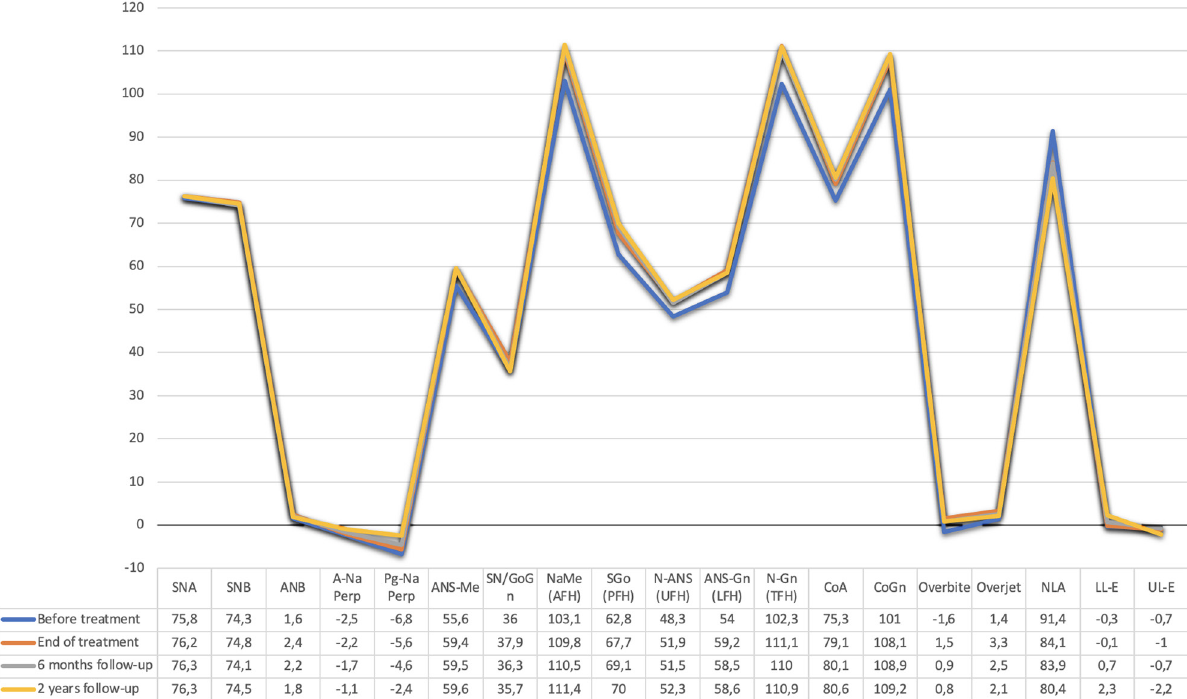
Figure 8. Graphical representation of cephalometric changes that occurred because of orthodontic treatment and subsequent growth and